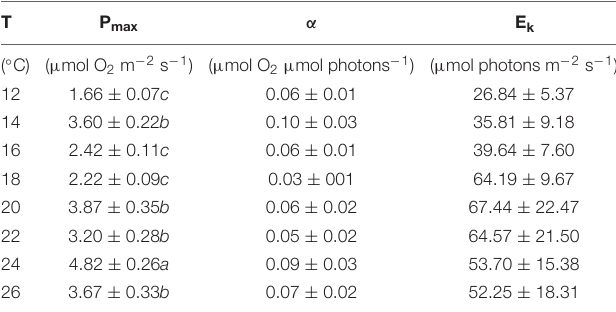
TABLE 1 | Parameters from photosynthesis–irradiance (P–E) curves at different temperatures (12–26 ◦ C): maximum photosynthetic rates (P max ), ascending slope at limiting irradiances ( α ), and half-saturation irradiation (E k